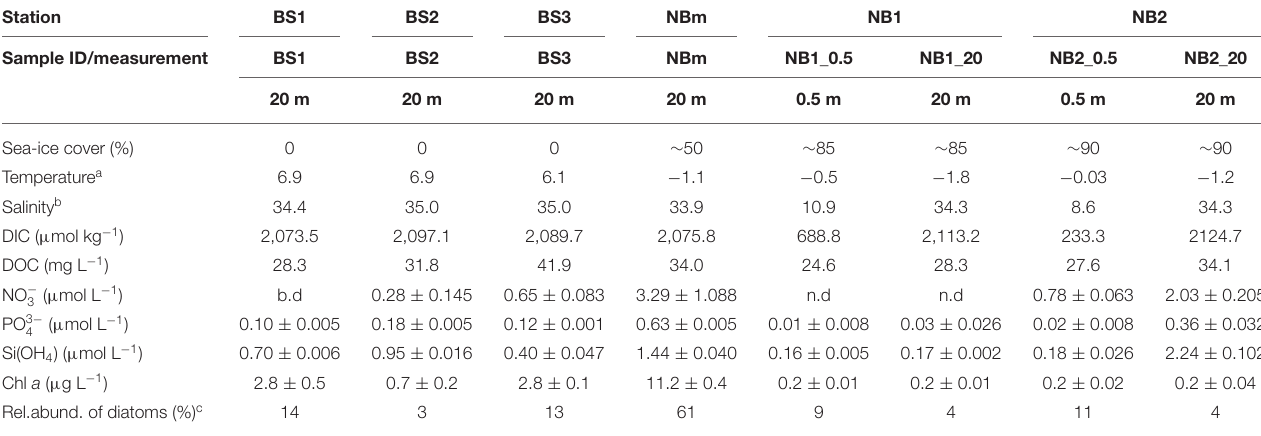
TABLE 1 | Summary of the measured and analyzed physical and biogeochemical environmental factors (mean ± standard deviation) at the depth of sampled microbial communities. Station BS1 BS2 BS3